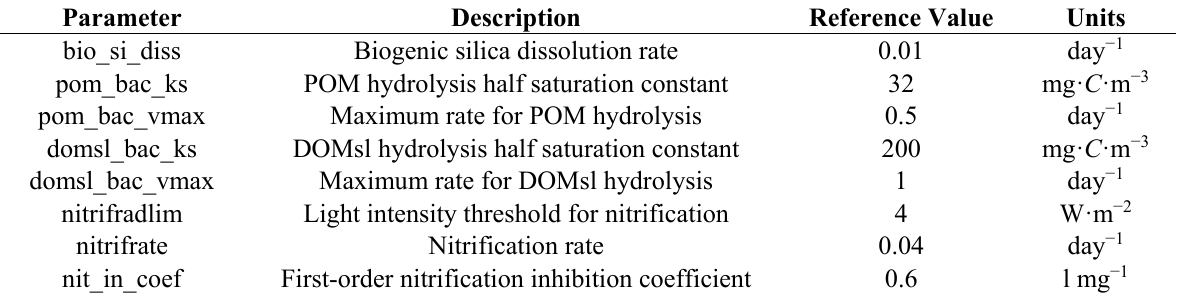
Table 5. General parameters (not necessarily related with any functional